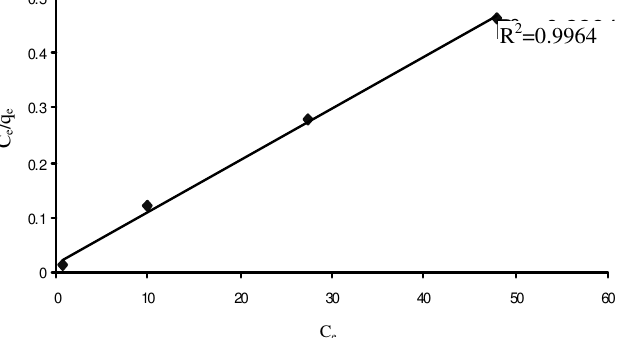
Figure 5. Langmuir plots for crystal violet adsorption